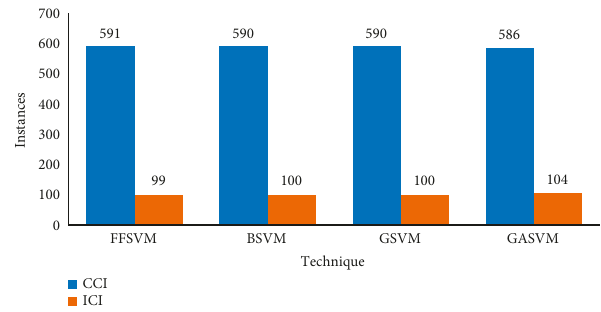
Figure 7: Classification of credit card transactions as correctly classified instances (CCI) and incorrectly classified instances (ICI). The outcomes show that the proposed approach has performed well, with the highest correctly classified instances of 591 and incorrectly classified instances of 99 over 690 CC applications than the three different hybrid algorithms. Table 7: Abbreviation used in this research paper.